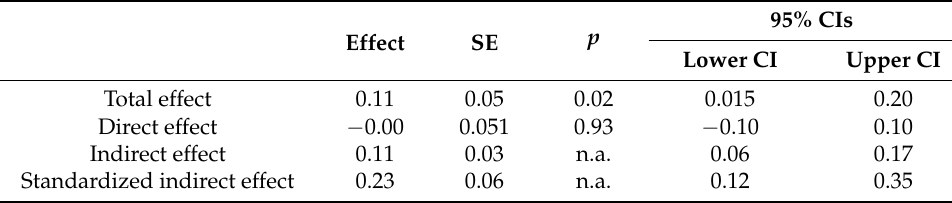
Table 4. Effects in the mediation